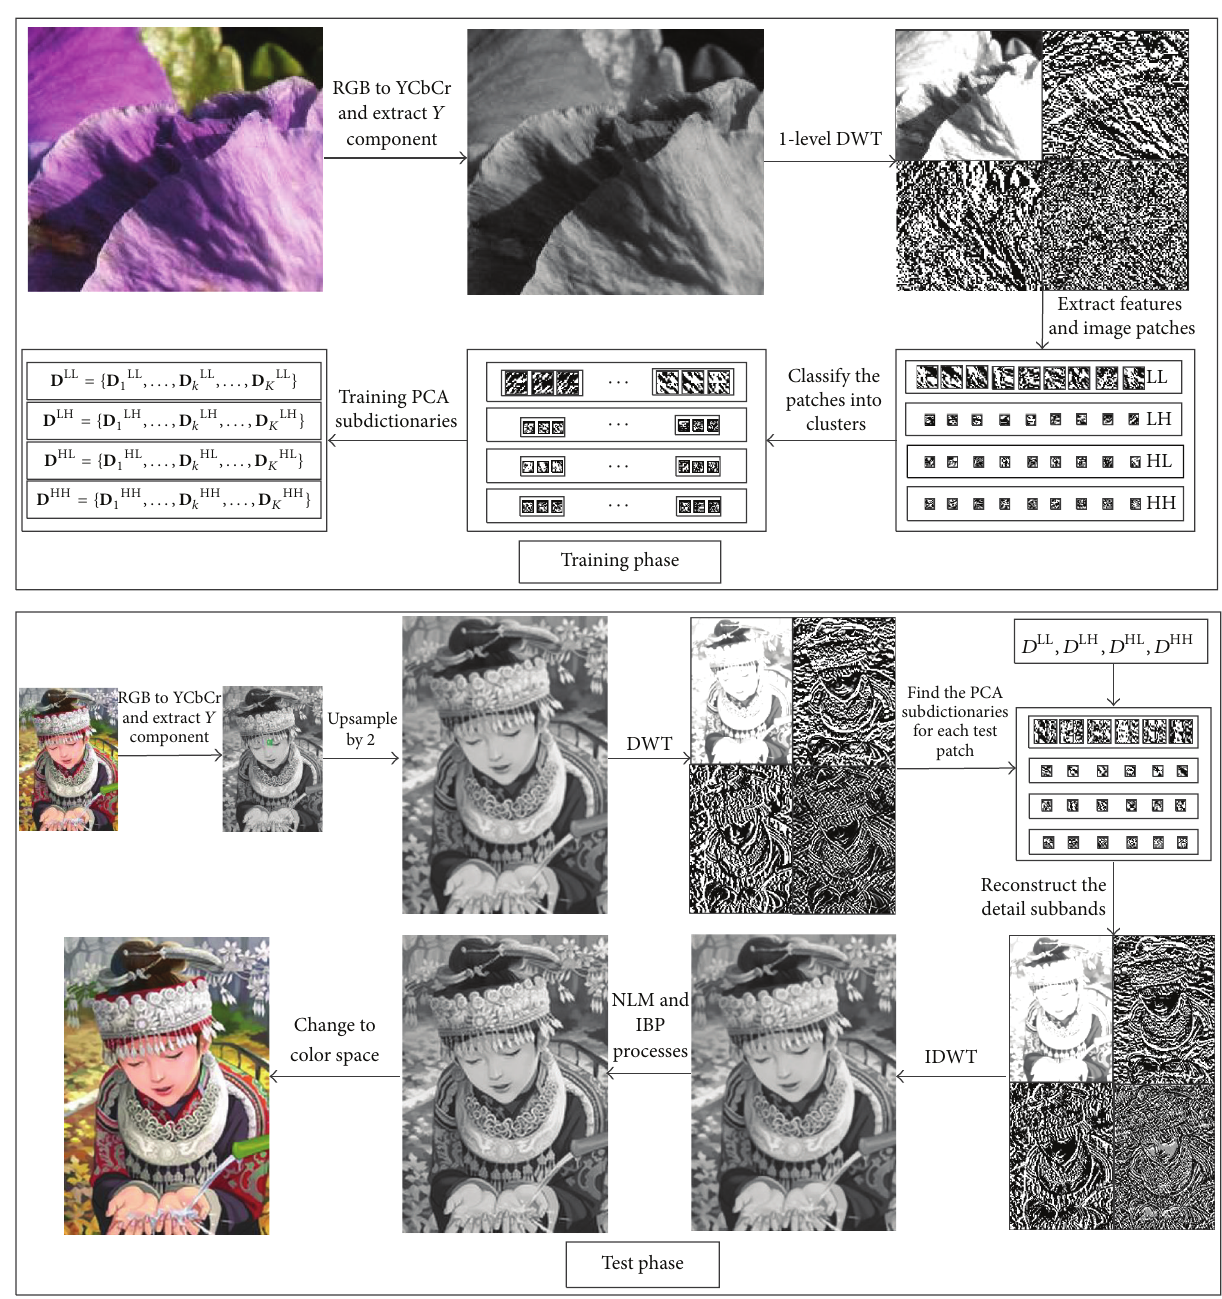
Figure 2: The flowchart of our proposed